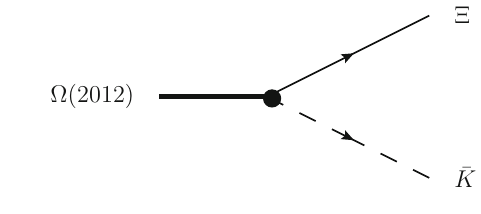
Fig. 1 The effective (cid:2)( 2012 ) → ¯ K (cid:3) decay in d -wave